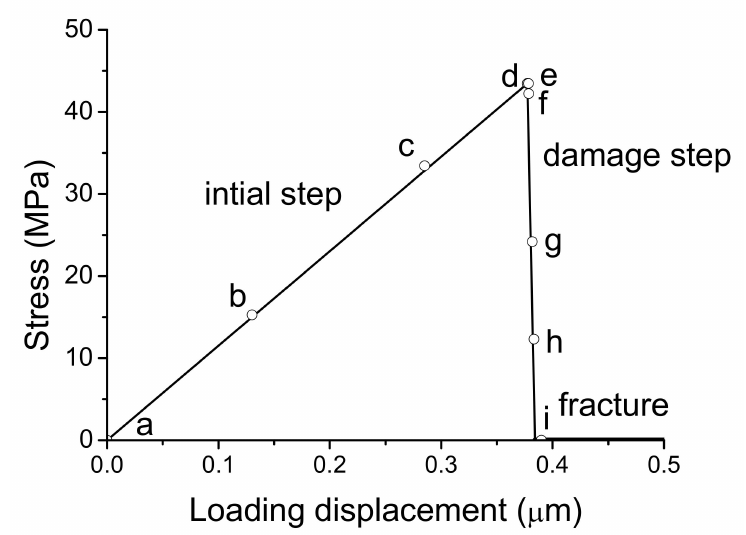
Figure 4. The total tensile stress-displacement relation of nanocrystalline film/substrate structure. The Mises stress evolution corresponding to a–i points in the curve were showed in Figure